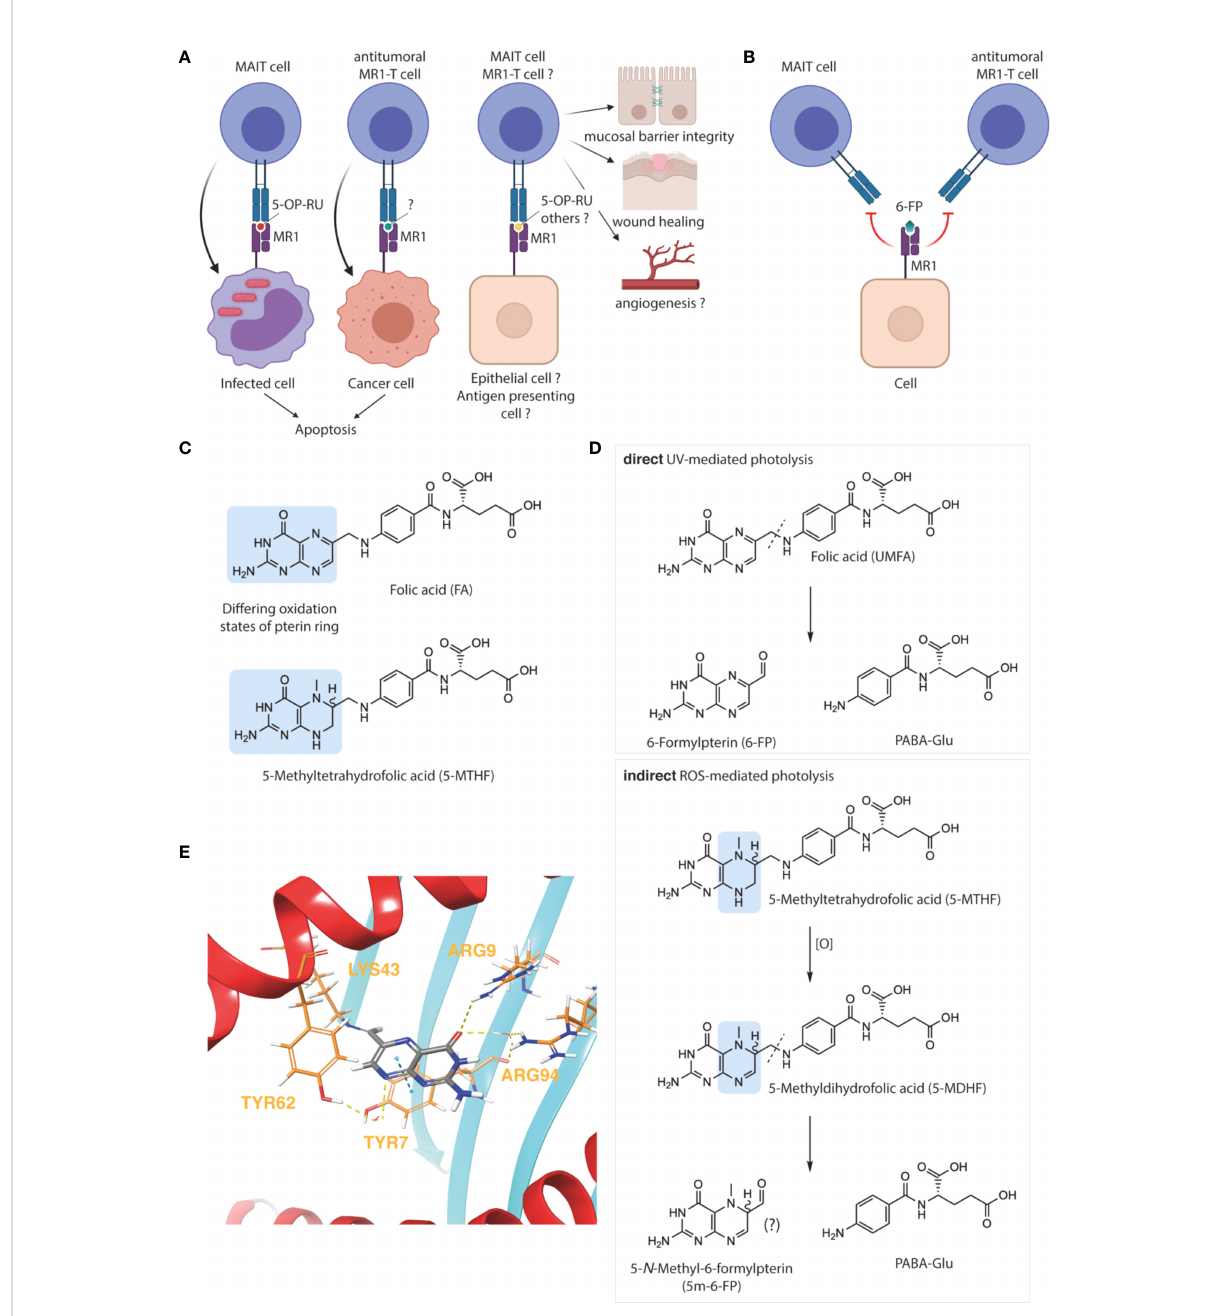
FIGURE 1 Oxidative degradation of folate and its relevance for MR1 immunobiology. MR1 – restricted T cells have varied biological functions (A) , which are blocked by 6 – formylpterin (6 – FP) (B) , image created with BioRender. The folate vitamers folic acid (FA) and 5 – methyltetrahydrofolate (5 – MTHF) differ in their pterin ring and oxidation states, highlighted in blue (C) . FA undergoes direct photodegradation to 6 – FP and p – aminobenzoyl glutamic acid (PABA – Glu) upon UVA exposure ( D , upper panel). In contrast, the photodegradation of 5 – MTHF is indirect and likely mediated by reactive oxygen species (ROS). The pterin photo – metabolite of 5 – MTHF has not yet been formally characterized but could hypothetically be 5 – N – Methyl – 6 – formylpterin (5m – 6 – FP) ( D , lower panel). Binding mode of 6 – FP to MR1 (PDB ID: 4L4T) was visualized using the Maestro software suite (E) . The protein was prepared using the Schrodinger protein preparation wizard and docked using CovDock. Key MR1 amino acid residues interacting with 6 – FP (gray), either covalently (LYS43) or non – covalently (ARG9, ARG94, TYR7 and TYR62), are marked in yellow and non – covalent interactions represented by dashed lines. H – bond interactions between various contact points of 6 – FP with ARG9, ARG94, or TYR62 ( via a water molecule) are represented by dashed yellow lines. The p – stacking interaction between the pterin ring of 6 – FP with the aromatic ring of TYR7 is represented by a dashed blue line (E)